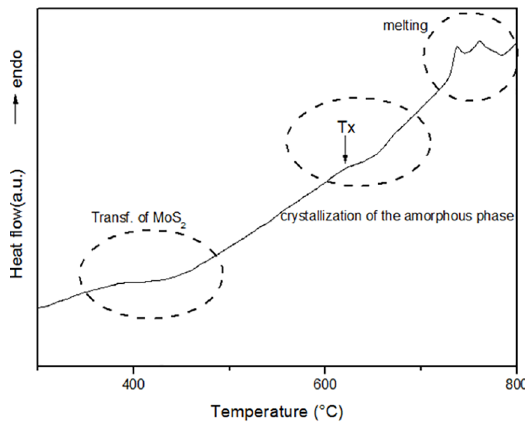
Cr Nb B (at%) + 5wt% MoS 60 8 8 24 , crystallization and 2 means crystallization x